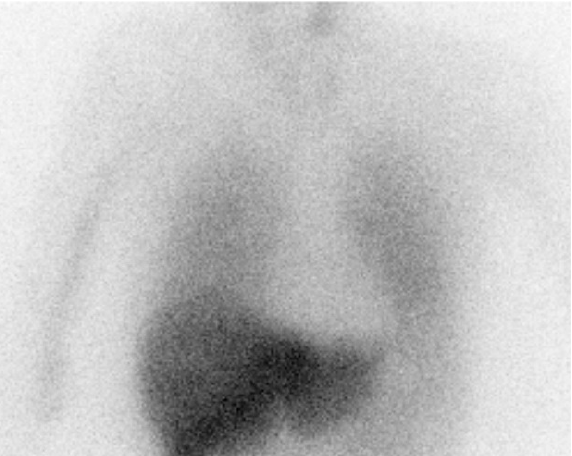
Figure 4. 123 I-MIBG myocardial scintigraphy image taken 3 h after injection. The image shows reduced uptake on 123 I-MIBG in the heart, indicative of dysfunction in the postganglionic sympathetic cardiac innervation.